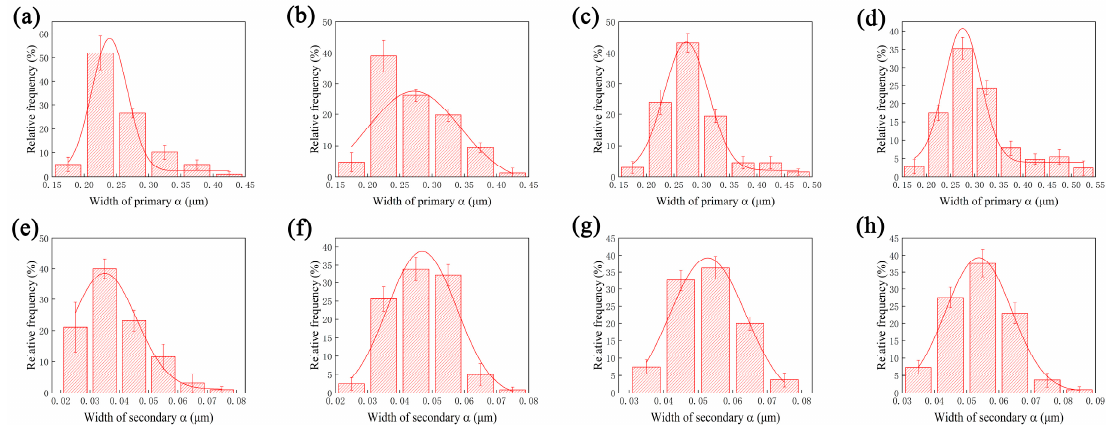
Figure 10. The primary and secondary width distributions of Ti-35421 that was solution-treated at 780 °C for 1 h and aged at 540 °C for different lengths of time time: ( a ) and ( e ) 2 h; ( b ) and ( f ) 4 h; ( c ) and ( g ) 8 h; ( d ) and ( h ) 16 h.